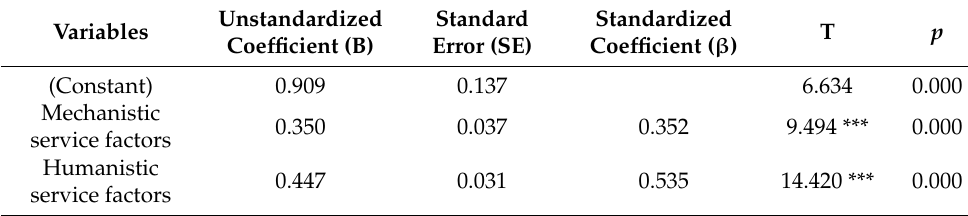
Table 9. Effect of service factors on user satisfaction.